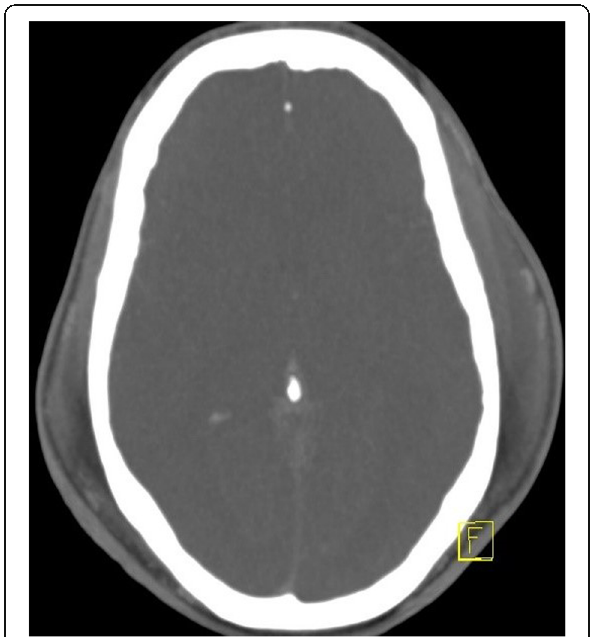
Fig. 6 Brain Scan, 03/18/2020, evidence for brain